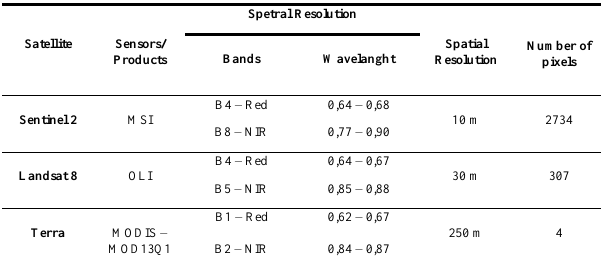
Table 1. Spectral and spatial resolution of the sensors used and total pixels present in the study area of each